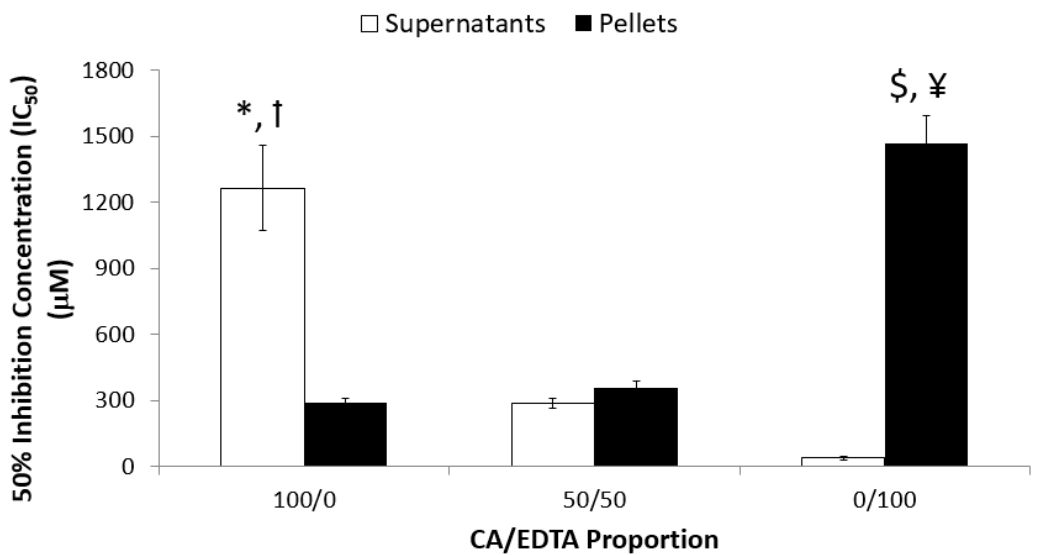
Figure 3. CeNPs stabilized with only CA display the highest SOD-mimetic activity in the pellet fractions, and SOD activity was highest in the supernatant fractions of CeNPs stabilized only with EDTA. SOD-mimetic activity was measured using a commercial kit (as described in the methods) where the concentration of each type of CeNP that was equivalent to 1 unit of SOD activity was determined. A higher IC 50 indicates lower SOD activity. Data are presented as mean ± SEM of n = 4–5 separate experiments in which each sample was assayed in triplicate. A two-way ANOVA indicated an interaction between centrifugation fraction and stabilizer ratio (F 2,21 = 70.30, p < 0.0001). Post-hoc comparisons were made with the Bonferroni correction for multiple, preplanned comparisons. Symbols indicate p < 0.05: *compared to 100/0 pellet; ꝉ compared to 50/50 and 0/100 supernatant; $ compared to 0/100 supernatant; ¥ compared 100/0 and 50/50 pellet.